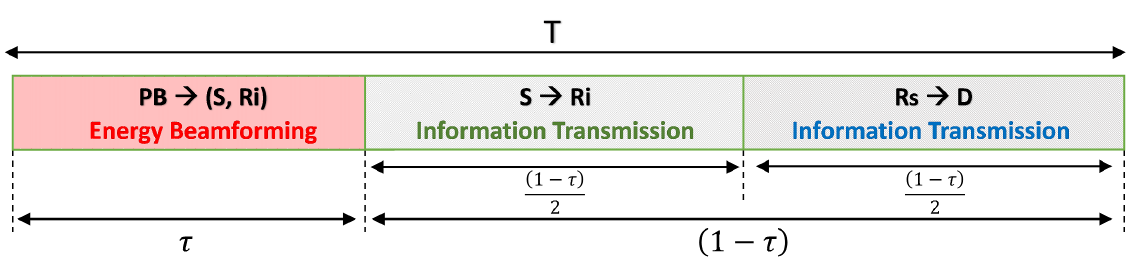
Figure 2. Diagram of the time switching harvest then cooperate protocol